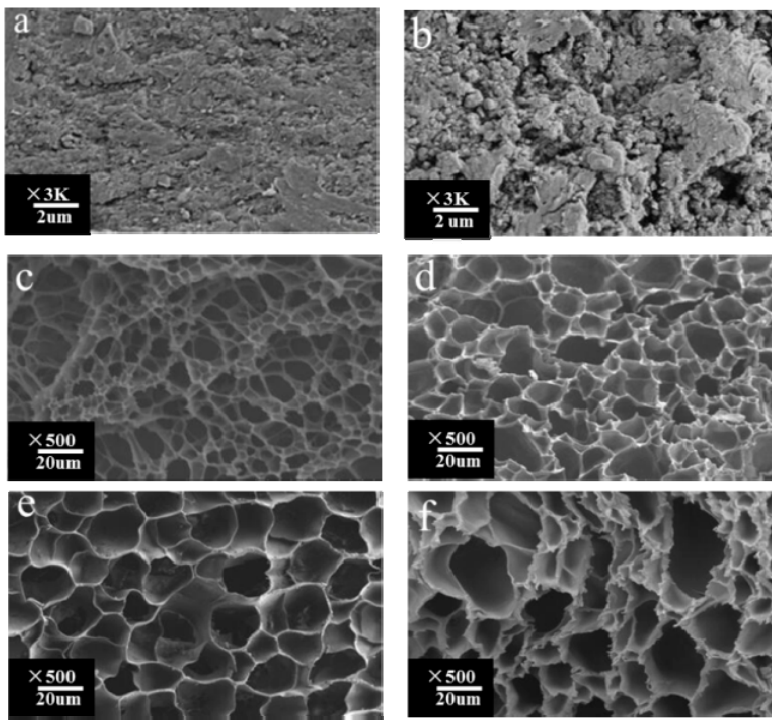
Figure 3. SEM images of xylan ( a ); MAHX ( b ); and freeze-dried gel-1 ( c ); gel-2 ( d ); gel-3 ( e ); and gel-4 ( f ). The hydrogel samples swelled at 37 °C and freeze-dried before determination.